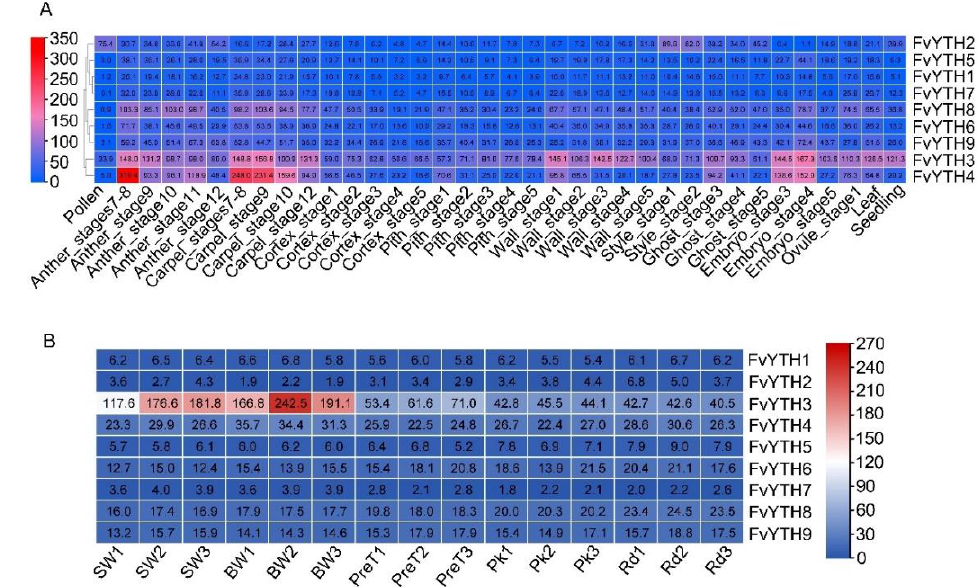
Figure 6. Heat map of FvYTH genes in strawberry. ( A ) Heat map of FvYTH gene expression in different tissues and organs at different development stages. The tissues and organs used for the expression profiling are indicated at the bottom of each column. ( B ) Heat map of FvYTH gene expression in different development stages of fruit. SW: small white stage; BW: big white stage; PreT: pre-turning stage; Pk: pink stage; Rd: red stage. The numbers 1, 2, and 3 represent three repetitions. TPM values are shown, and the color from blue to red shows the scaled TPM values.